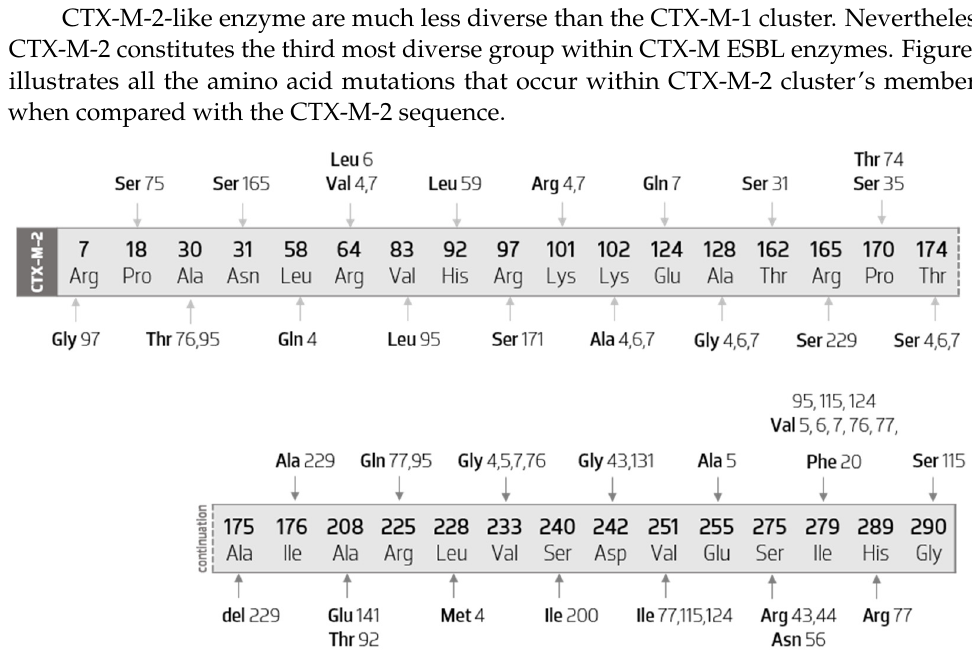
Figure 5. Diagram of the mutations of CTX-M-2 cluster’s members, compared with the CTX-M-2 sequence. Scheme based on available sequences and phenotypes in the Bacterial Antimicrobial Resistance Reference Gene Database.